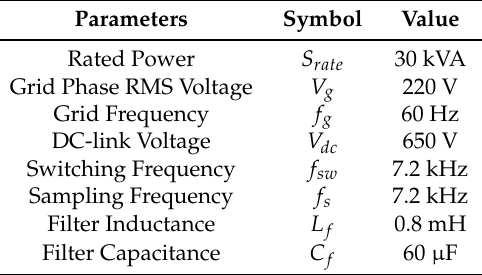
Figure 12. Hardware configuration for experiment. Table 1. Parameters for